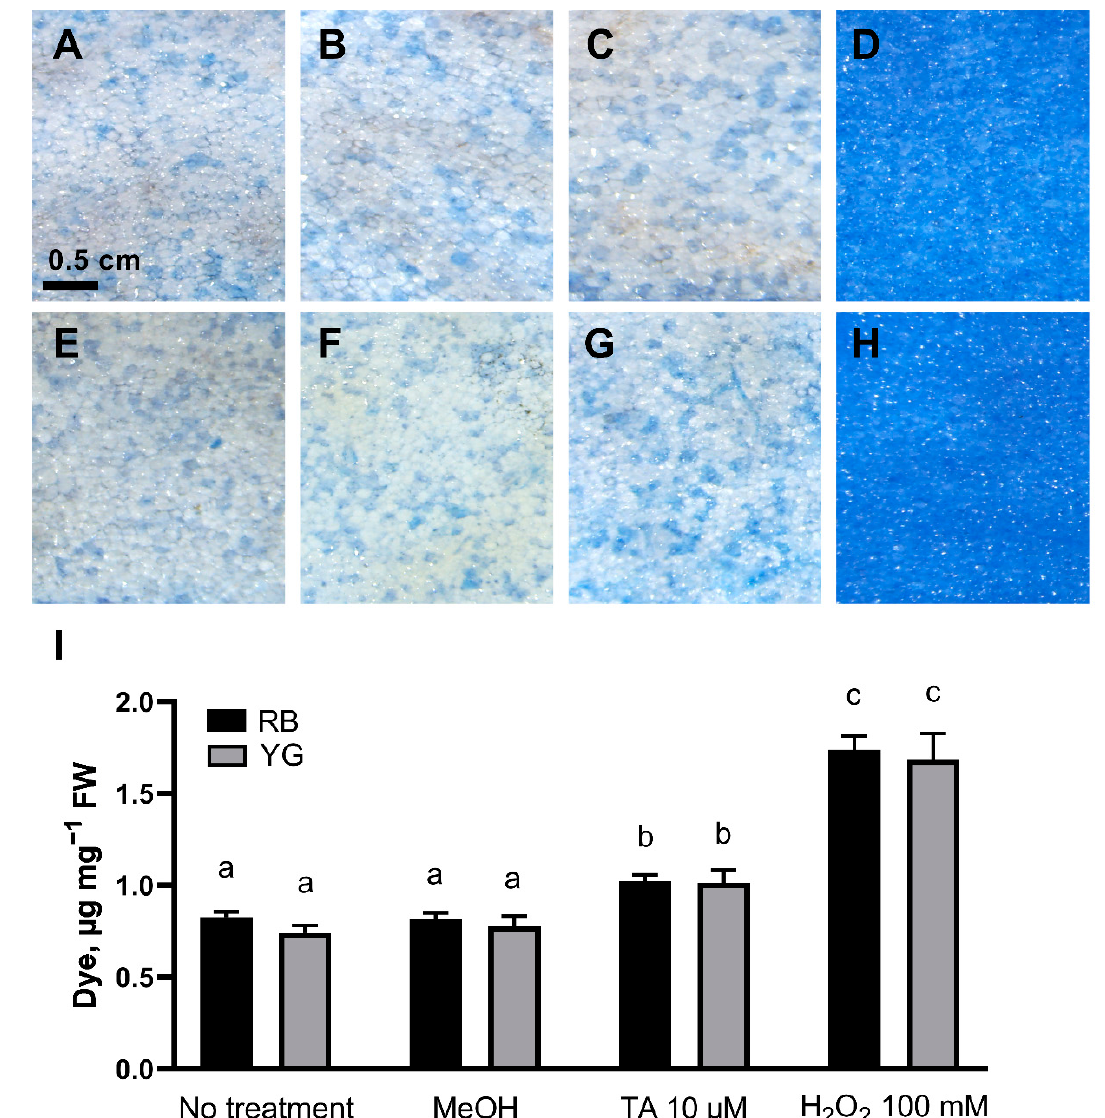
Figure 2. TA induces cell death in parenchymal cells of RB and YG tubers. Evans blue stained parenchyma sections of RB ( A – D ) and YG ( E – H ). ( A , E ) control conditions (no treatment); ( B , F ) sections treated with MeOH; ( C , G ) sections treated with 10 µ M TA, ( D , H ) sections treated with H 2 O 2 (100 mM) for 24 h. ( I ) Evans blue concentration ( µ g mg − 1 FW) in tuber parenchymal sections untreated or after treatments with MeOH, TA (10 µ M) or H 2 O 2 (100 mM) for 24 h. Data is presented as the mean ± SEM of 6 biological replicates; letters (a, b, c) indicate significantly different means according to two-way ANOVA followed by Fisher’s LSD ( p ≤ 0.05).